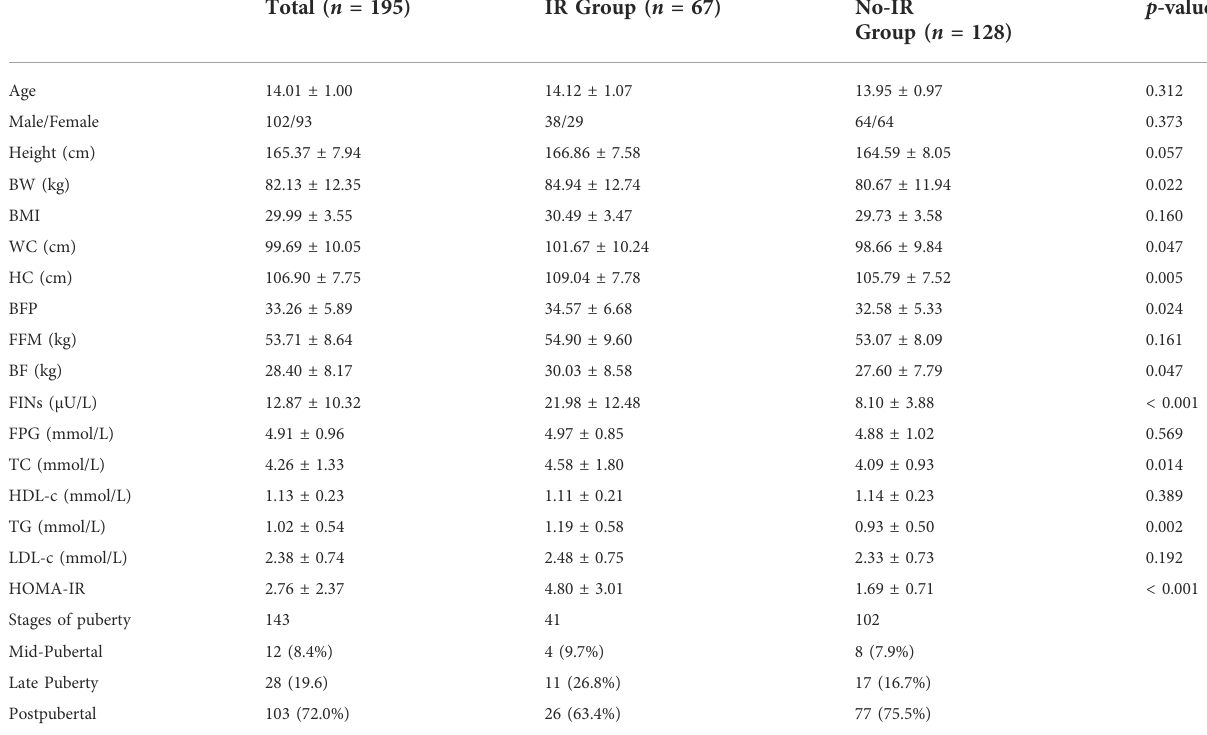
TABLE 1 Baseline characteristics of the participants.